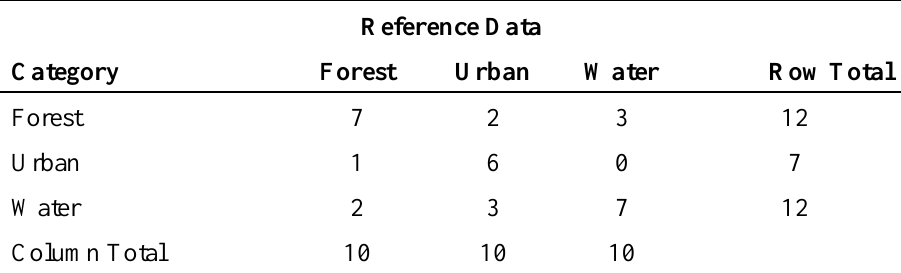
Table 4. Example of error matrix for classification